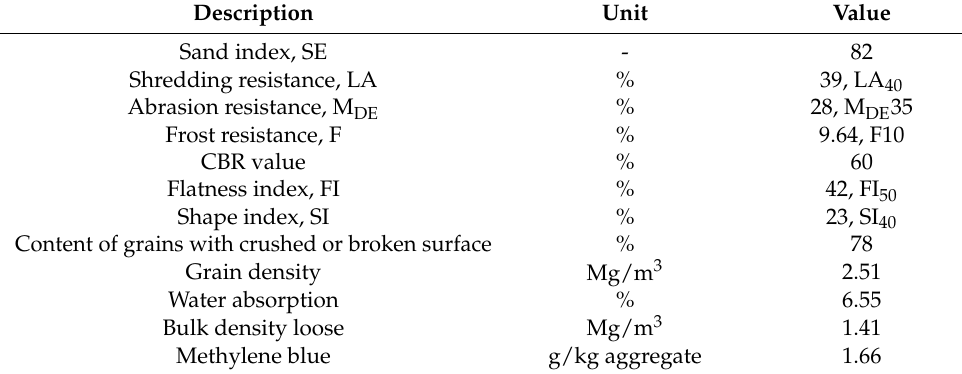
Table 4. Summary of test results for selected properties of concrete aggregate.